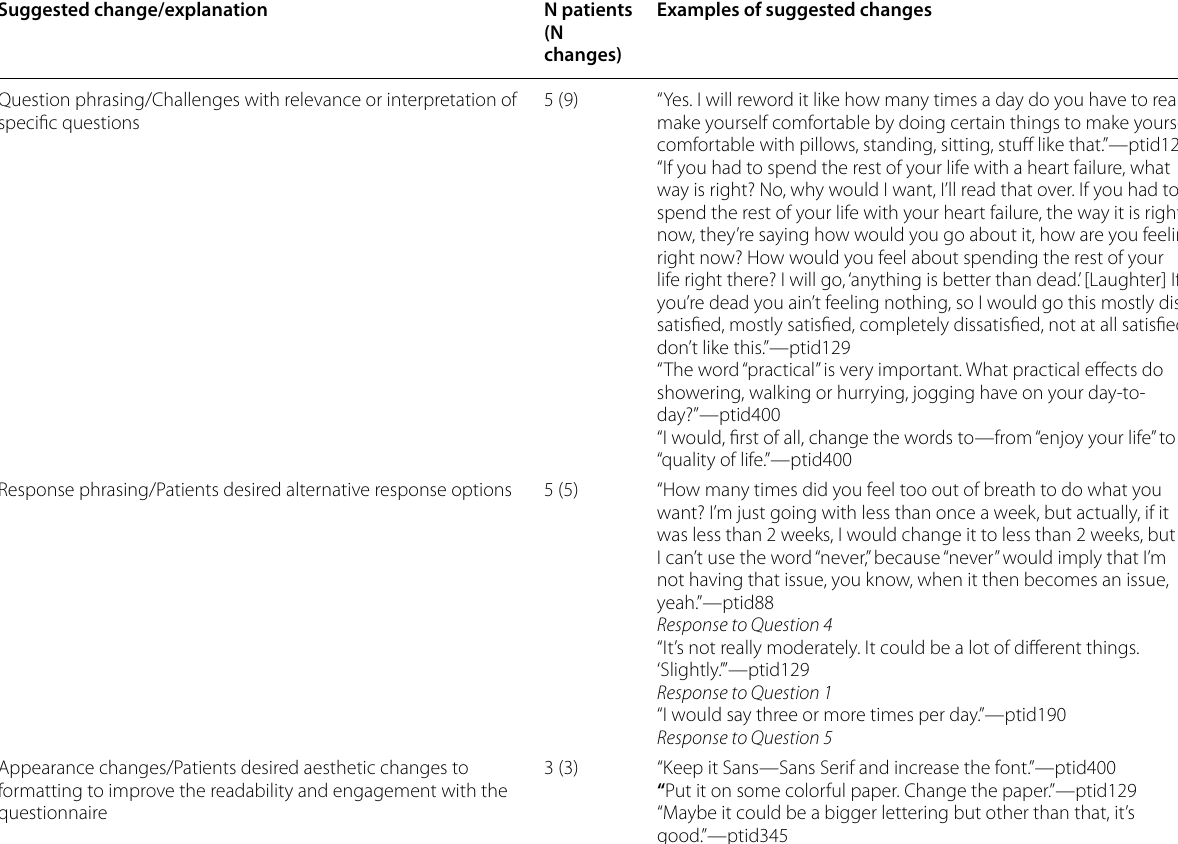
Table 2 KCCQ-12 feedback Suggested change/explanation N patients